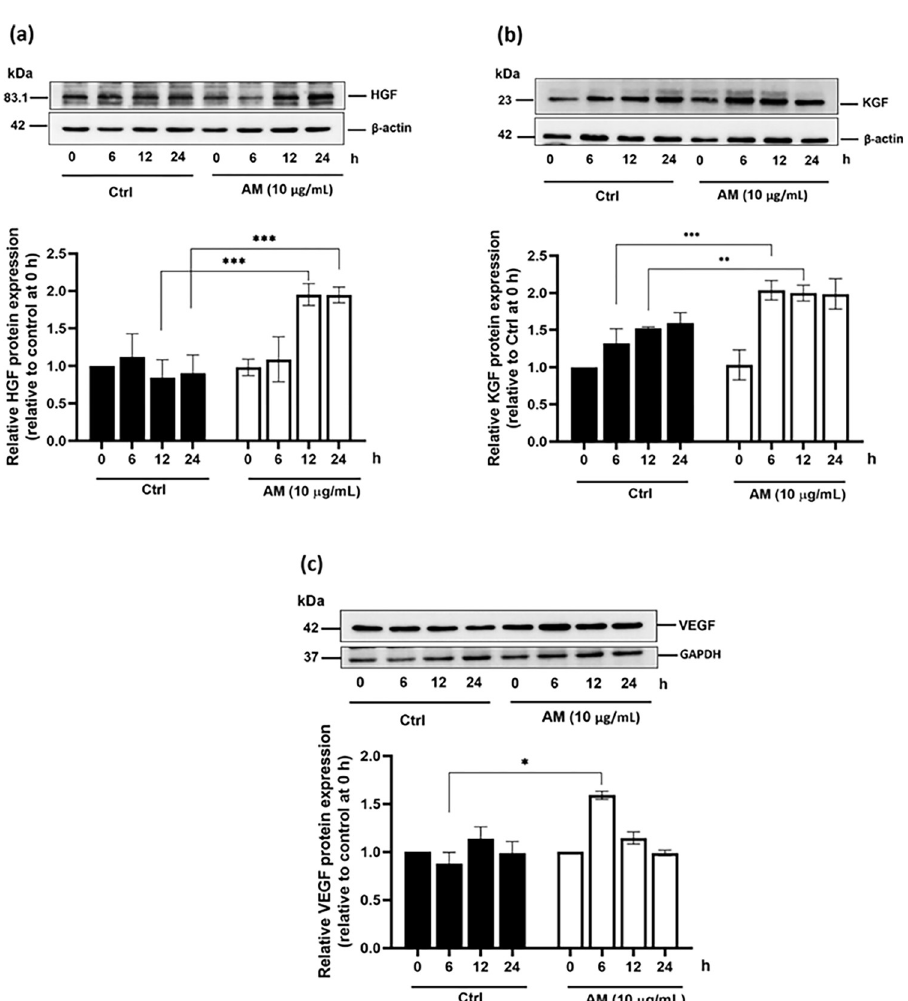
Fig 7. The effect of the AM extract on the protein expression of the hair growth factors. (a) VEGF, (b) HGF and (c) KGF. DPCs were incubated with T (30 μ M), and were treated with the AM extract (10 μ g/mL) for various periods (6, 12, and 24 h). DPCs incubated with only T (30 μ M) acted as a control. The protein expression is represented relatively to the control group levels at 0 h. The bar graph data analysis of the undertaken Western blotting shows the expression of VEGF (a), HGF (b), and KGF (c). All data are presented as mean ± SD (n = 3). * p < 0.05, ** p < 0.01, and *** p < 0.005 versus non-treated